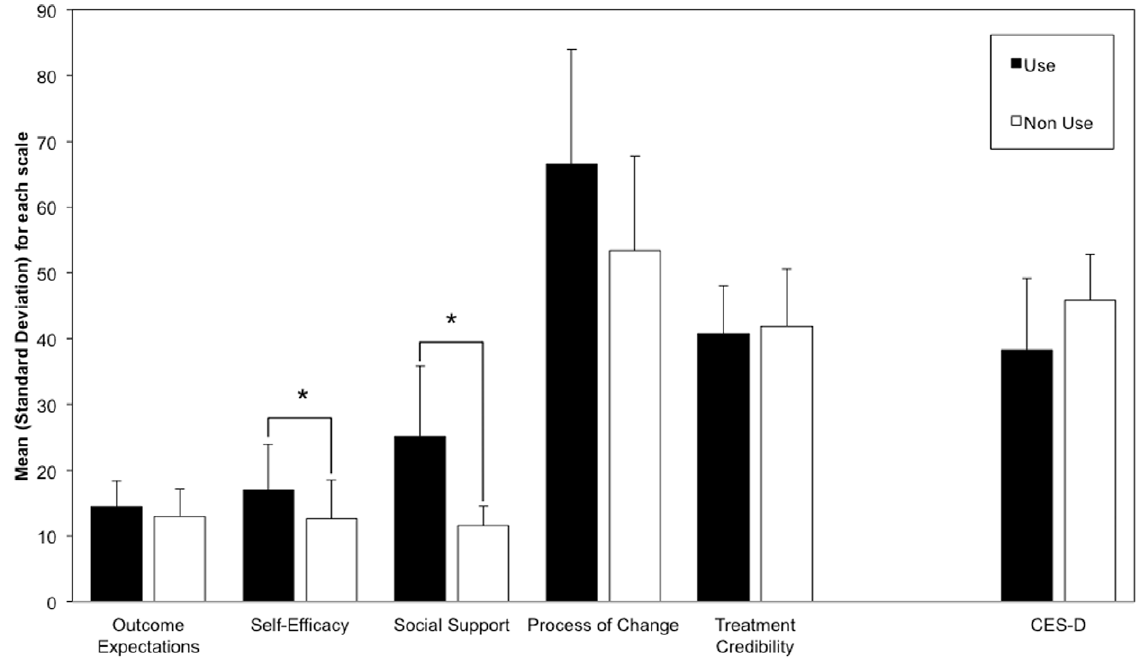
Figure 1. Comparison of motivation, credibility, and depression symptom scale scores between those reporting use vs. non-use of light therapy ( M,SD ). * p , .05. Each measure has a different scale and minimum/maximum values, and is only compared here between groups defined by self-reported use vs. non-use of light therapy. Use: Individuals who reported using LT. Non Use: Individuals reporting no use of LT in the previous winter.